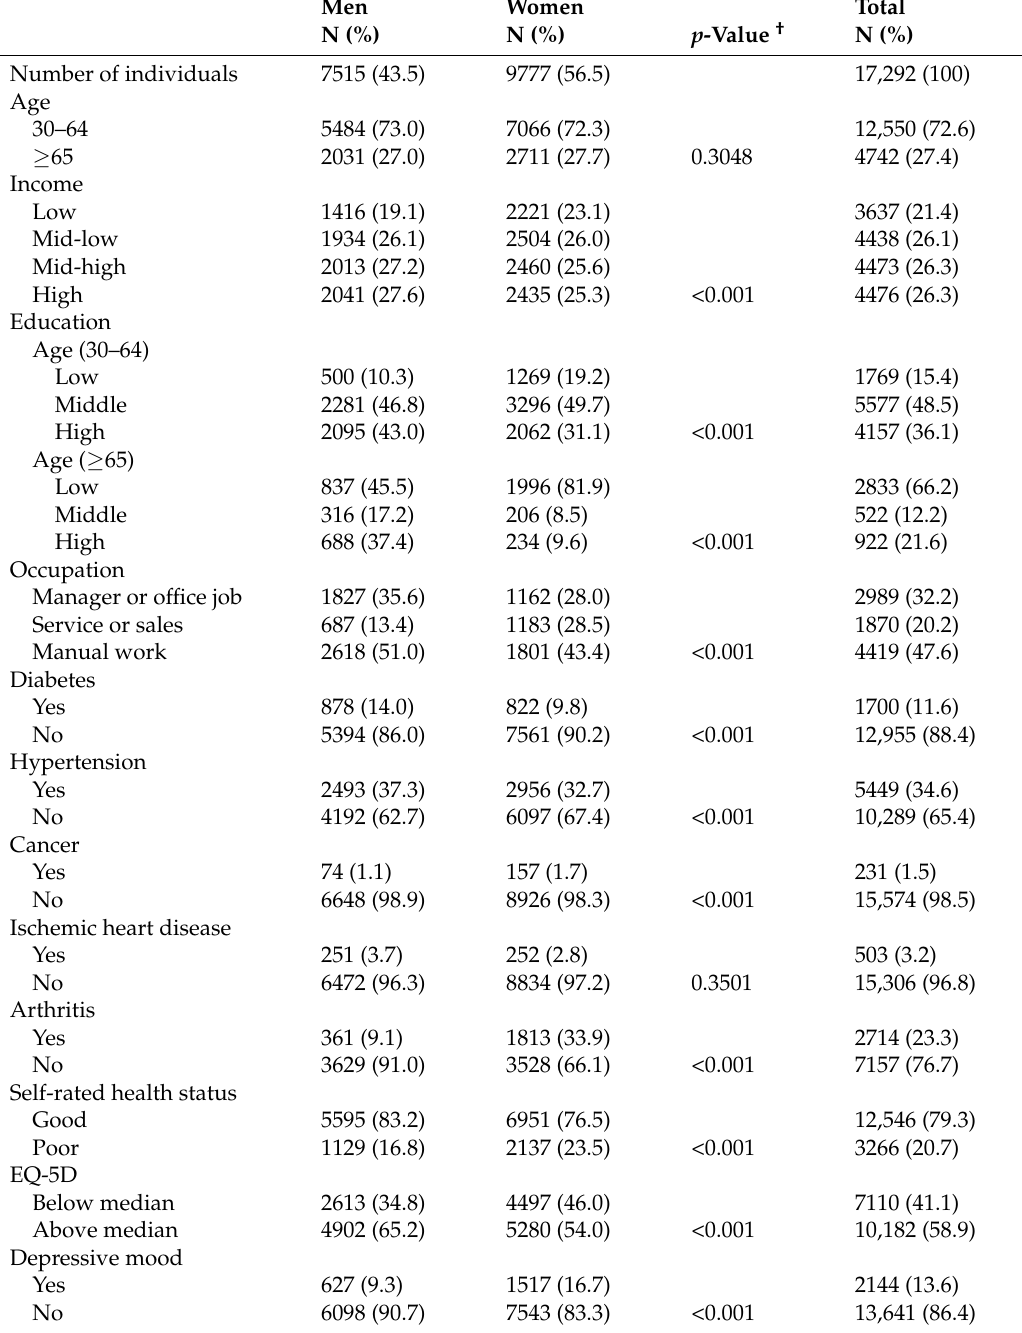
Table 1. Sociodemographic characteristics and health conditions and states of the study participants in KNHANES